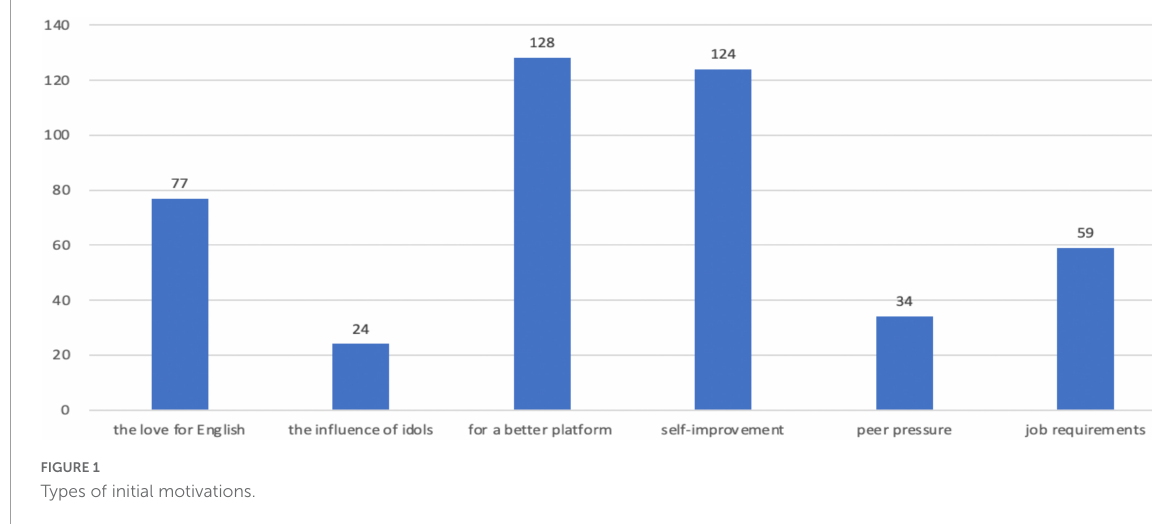
FIGURE1 Types of initial motivations.